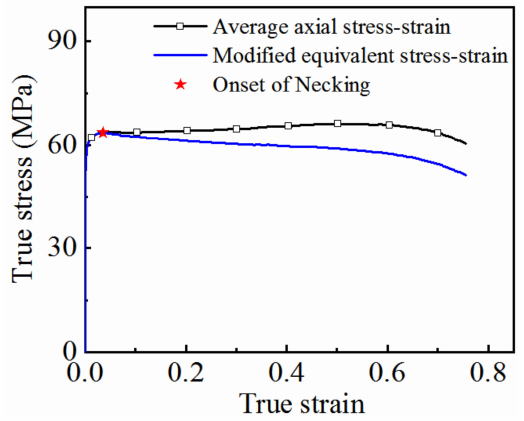
Figure 11. Modified equivalent stress–strain